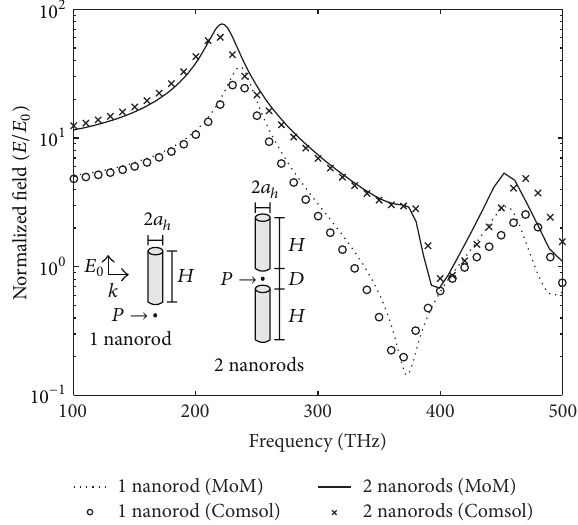
Figure 4: Normalized electric field near single and two nanorods at point 𝑃 (10nm from the nanorods edge), incident plane wave with amplitude 𝐸 0 . The nanorods are made of Au, 𝑁 = 11 , 𝐻 = 220 nm, = 10 nm, and 𝑑 = 20 nm. 𝑎 ℎ